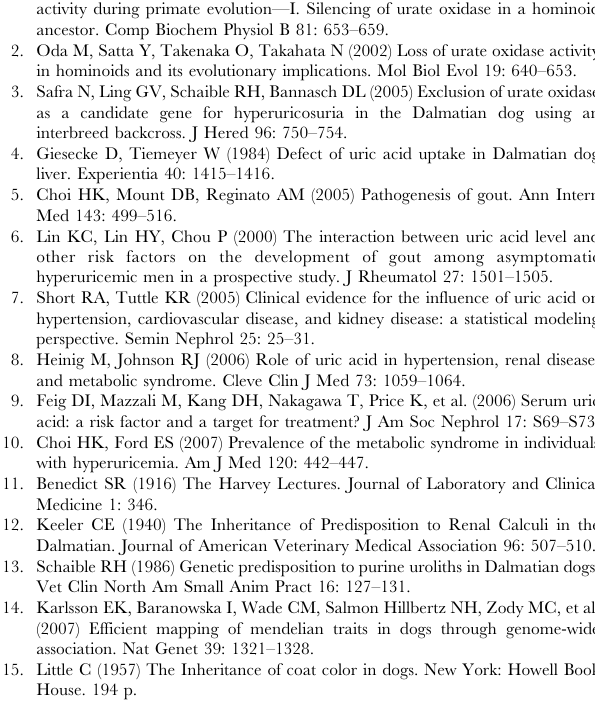
Table S1 Primers for microsatellite markers used to define the Huu region.